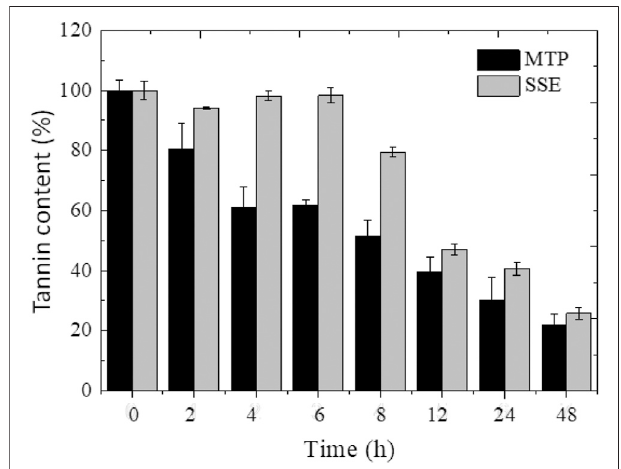
FIGURE 4 | Time-course of the MTP and SSE ef fl uents using Ca- alginatederivativecontaining A.fumigatus CAS21tannaseinthePBRfor48 h at 37 ° C with a fl ow rate of 5 ml min − 1